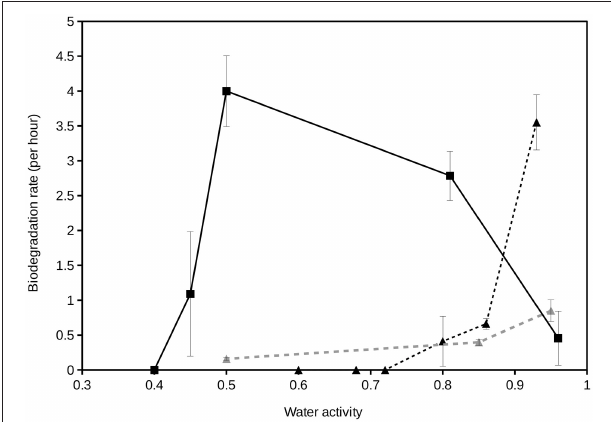
FIGURE 2 | Biodegradation of 2-CP in soil as a function of water activity for three bacterial species: a thermophilic Parageobacillus thermoglucosidasius (black continuous line and squares), and two mesophiles, Rhodococcus opacus (black discontinuous line and triangles) and R. erythropolis (gray discontinuous line and triangles). Note that the optimum 2-CP decomposition rate for the thermophilic species, P. thermoglucosidasius , was observed at water activity 0.5 (corresponding to a quite dry soil). For Rhodococcus , the optimum 2-CP decomposition rate occurred under soggy conditions, at water activity > 0.9. Error bars represent one standard